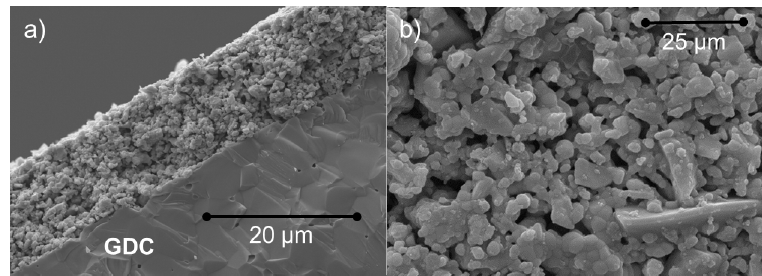
Figure 1. ( a ) Cross section SEM (Scanning Electronic Microscopy) image of the Pt-BaO/LSCF (La 0.6 Sr 0.4 Co 0.8 Fe 0.2 O 3 − δ )-GDC (Gd 0.2 Ce 0.8 O 1.9 )/GDC cell and ( b ) SEM image of the surface of the catalyst-electrode.